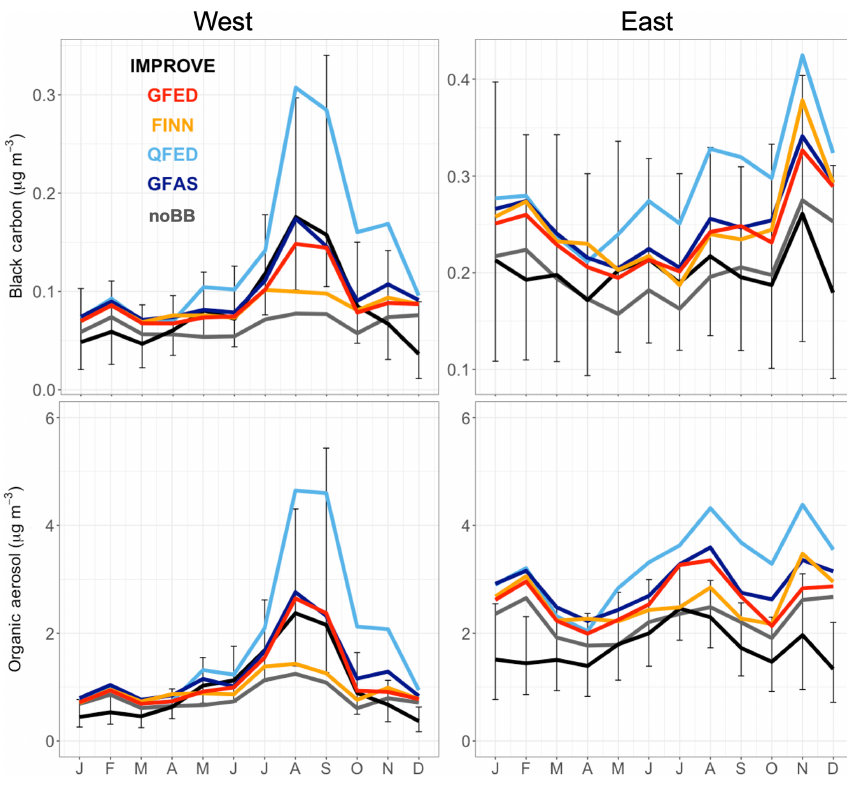
Figure 7. The 2012 monthly comparison of simulated and observed median surface concentrations at IMPROVE sites in CONUS split between east and west at − 104 ◦ W longitude. Observations in black are compared with concentrations simulated using GFED4s in red, FINN1.5 in orange, QFED2.4 in light blue, GFAS1.2 in dark blue, and a simulation with no biomass burning (noBB) in gray. Error bars show the 25th to 75th percentile range of observations. Note the different scales among